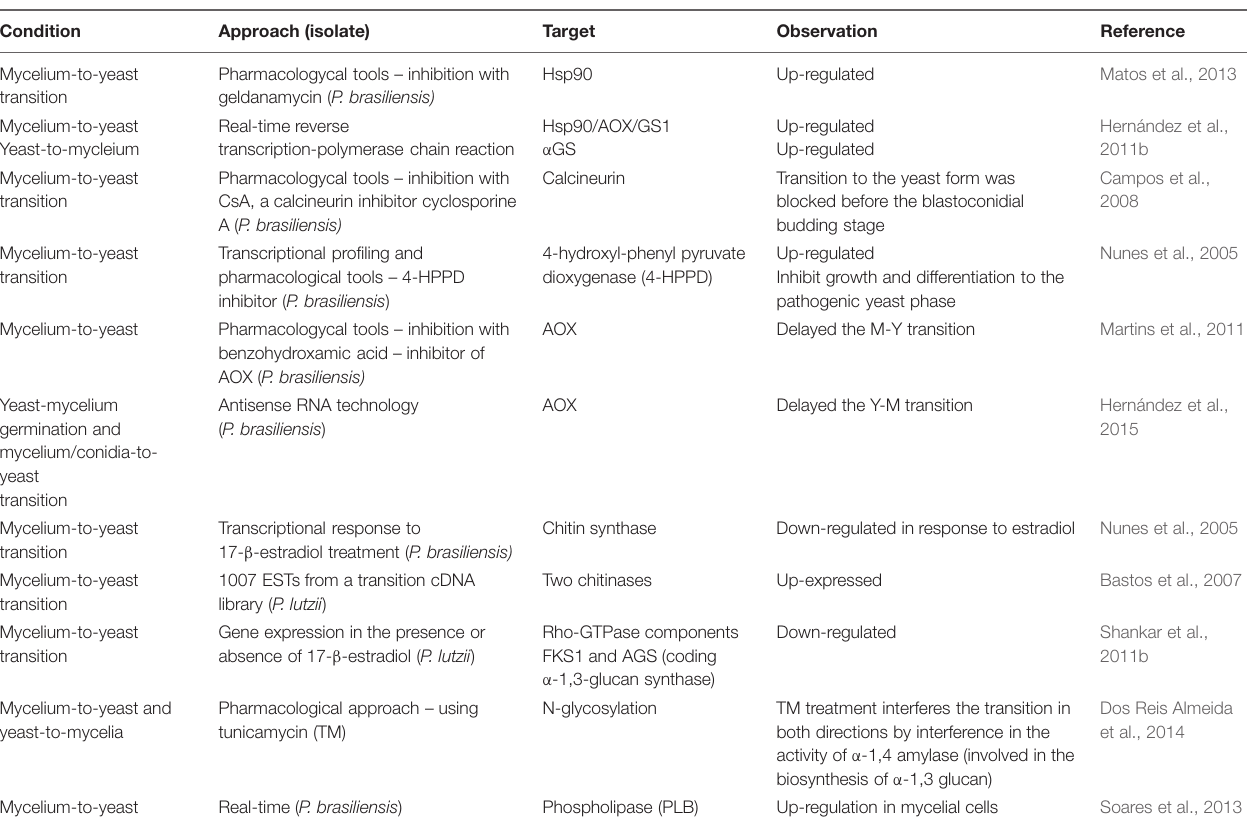
TABLE 2 | Summary of studies related to dimorphism of Paracoccidioides